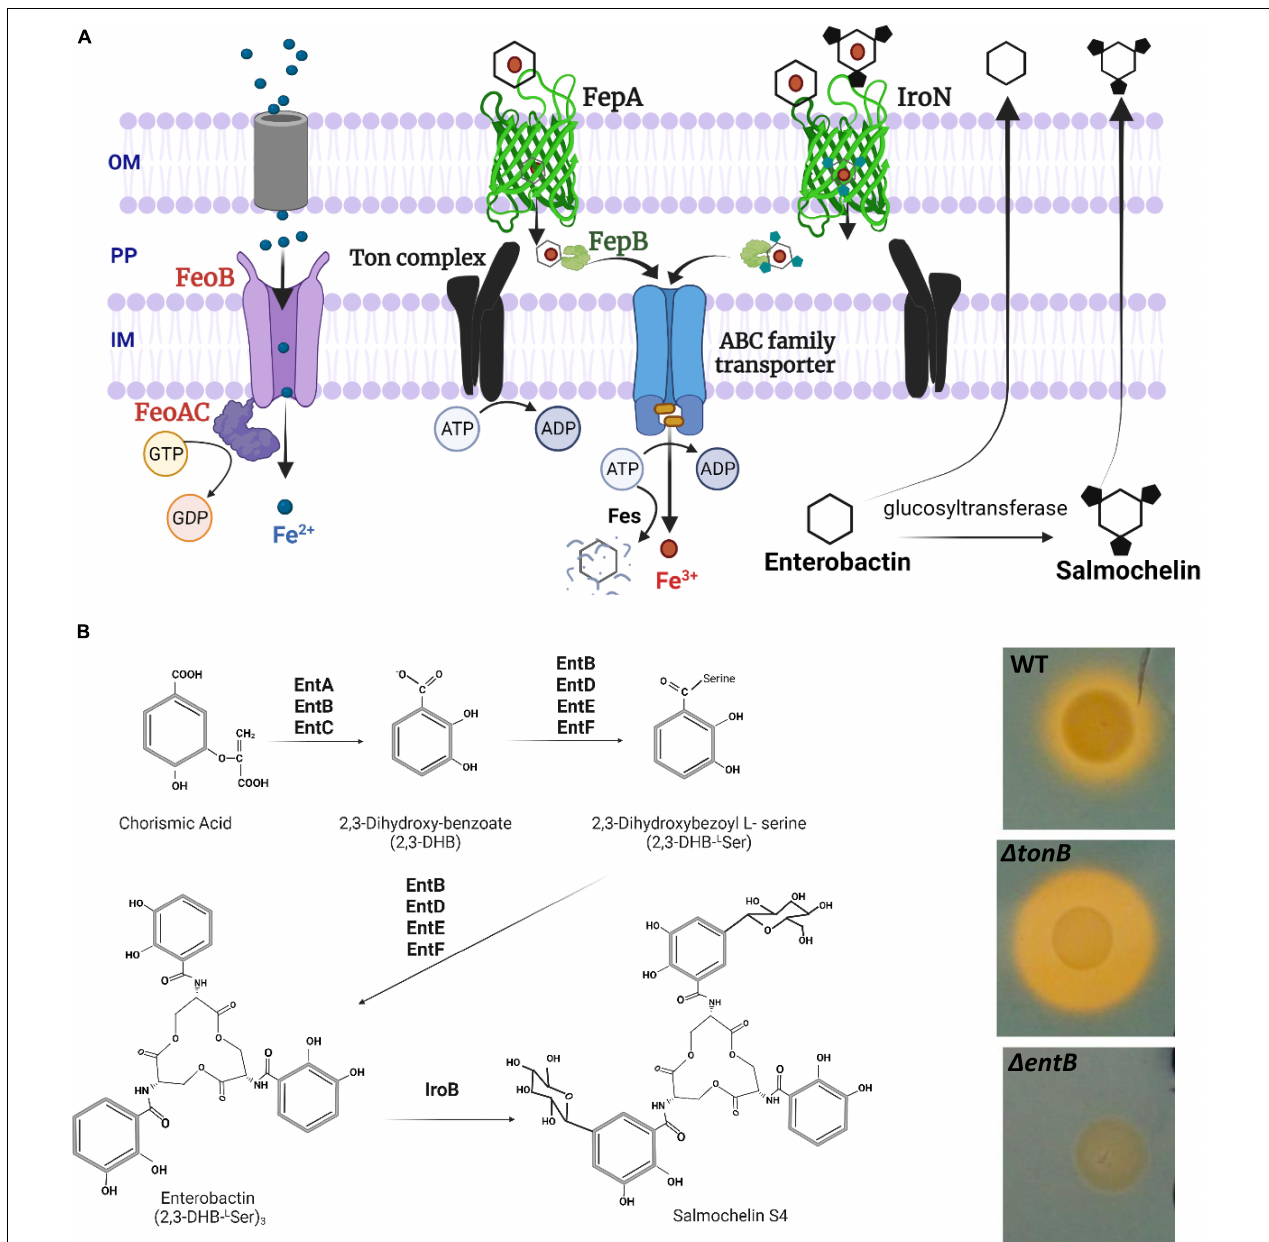
FIGURE 1 | (A) Ferrous iron and catecholate siderophore chelated ferric iron uptake via high affinity acquisition systems in Salmonella. OM, outer membrane; PP, periplasm; IM, inner membrane. Ton complex components (TonB-ExbB-ExbD) transduce the proton motive force from the inner membrane to outer membrane receptors to translocate the ferric-siderophore into the PP. FepB is the periplasmic binding protein to shuttle siderophores via ABC family transporter (FecC, FecD, FecE) into the cytoplasm. Fes (ferric enterochelin esterase) hydrolyzes the catecholate siderophore to release Fe 3 + . Not shown components involved in the transport of hydroxamate type ferric-siderophores and iron-dicitrate. (B) Siderophore biosynthesis in key steps. Enzymes involved in enterobactin synthesis are encoded by entCEBA operon and entF transcribed separately. IroB represents a glucosyltransferase. Detection of siderophore production using chrome azurol S agar plate is shown on the right side. Five µ L of overnight cultures were spotted onto the agar plate and incubated at 37 ◦ C overnight. A yellow halo is indicative of siderophore mediated ferric iron chelation. WT, wild type (LS101 SEn).